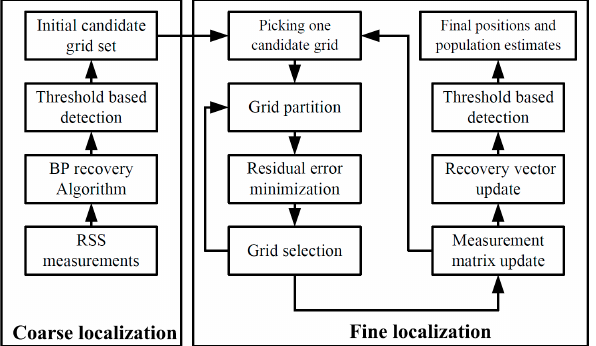
Figure 1. Block diagram of the proposed CS-based positioning scheme.